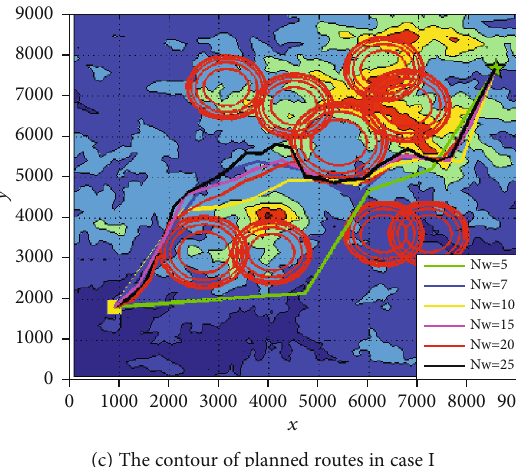
Figure 6: The comparison of results with di ff erent numbers in case